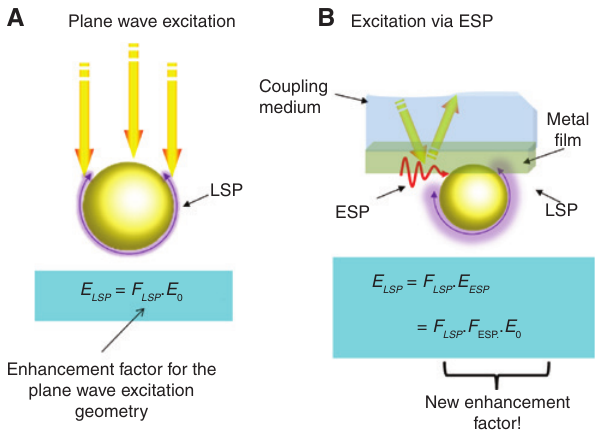
Figure 12: Schematic to explain the main concept for the ultrahigh enhancement geometry excitation of LSPs via (A) plane waves and (B) extended SPWs.